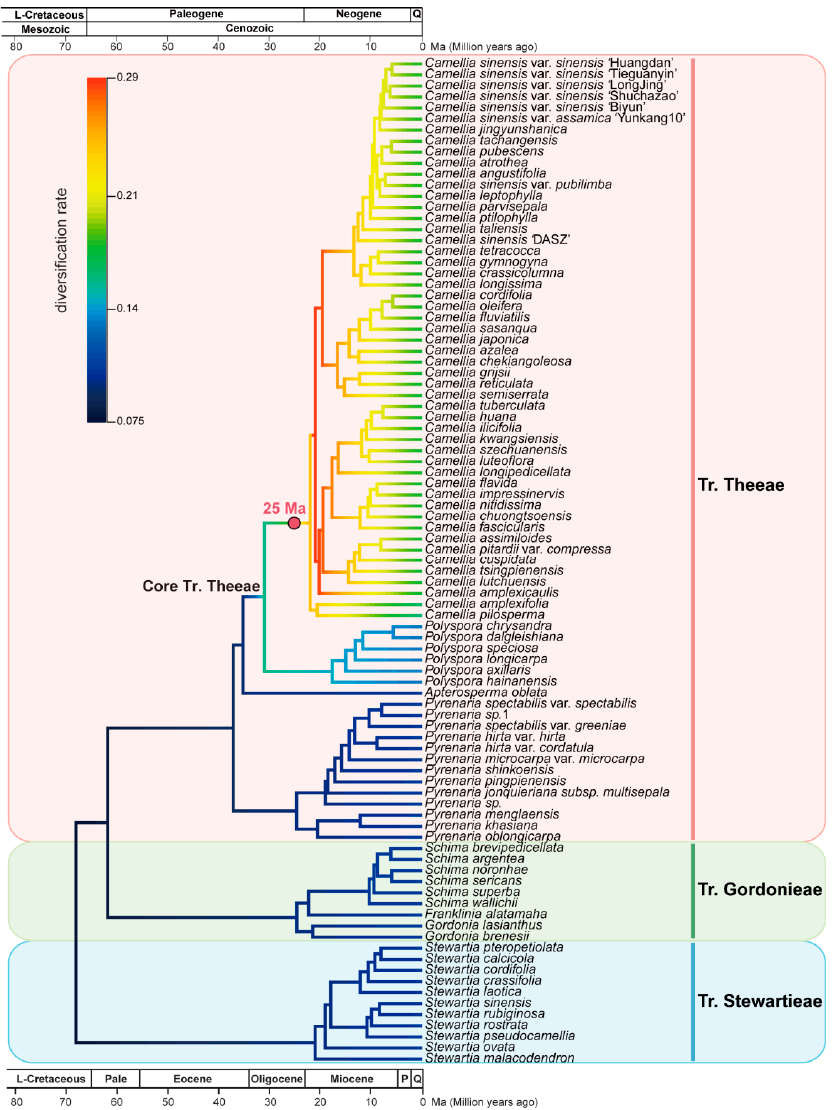
Figure 7. Diversification rate shifts in Theaceae. The red circle is species diversification rate shifts estimated by BAMM. The colors of branches show the mean diversification rate (species/million years) from BAMM. The geological timescale is illustrated at the top and bottom. The geological timescale at the bottom is in million years. L-Cretaceous, Late Cretaceous; Pale, Paleocene; P, Pliocene; Q, Quaternary. The pink, green and blue vertical line on the right indicates Tr. Theeae, Tr. Gordonieae and Tr. Stewartieae,